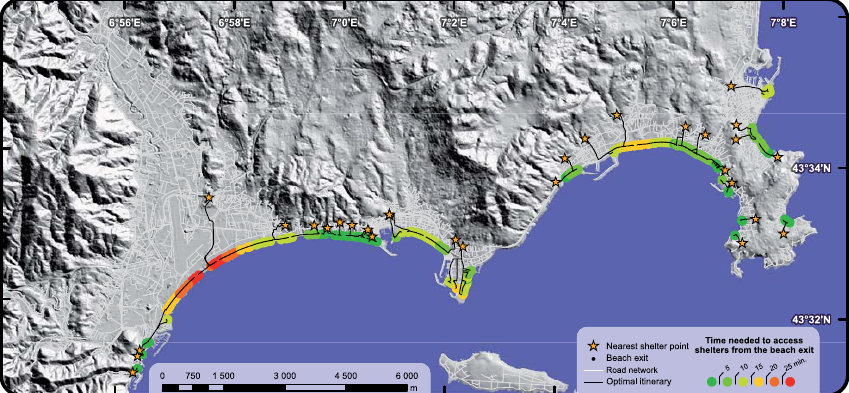
Fig. 7. Access time from beach exits to nearest shelter